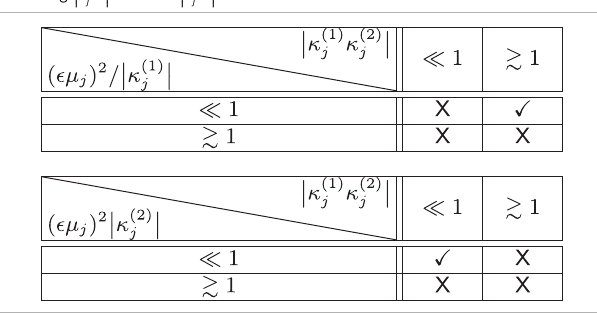
TABLE 2 | Validity of the condition ( Eq. 46 ) depending on the scales κ ( 1 ) j and κ ( 2 ) j